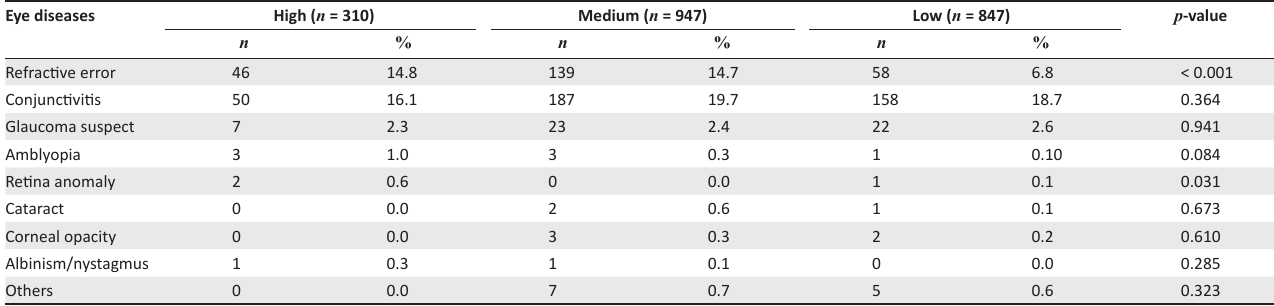
TABLE 5: Prevalence of eye diseases by socio-economic status of